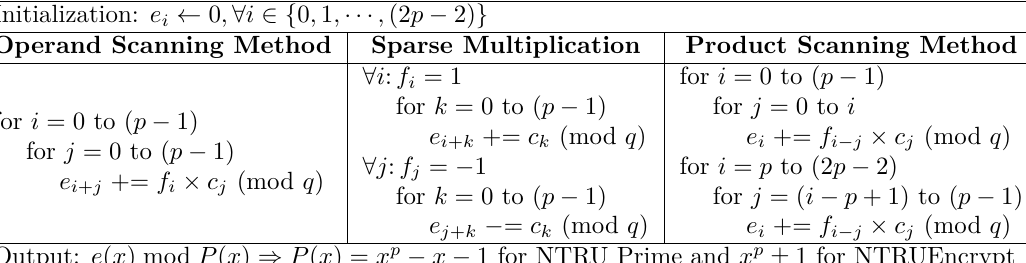
Table 1: The Polynomial Multiplication in R q in